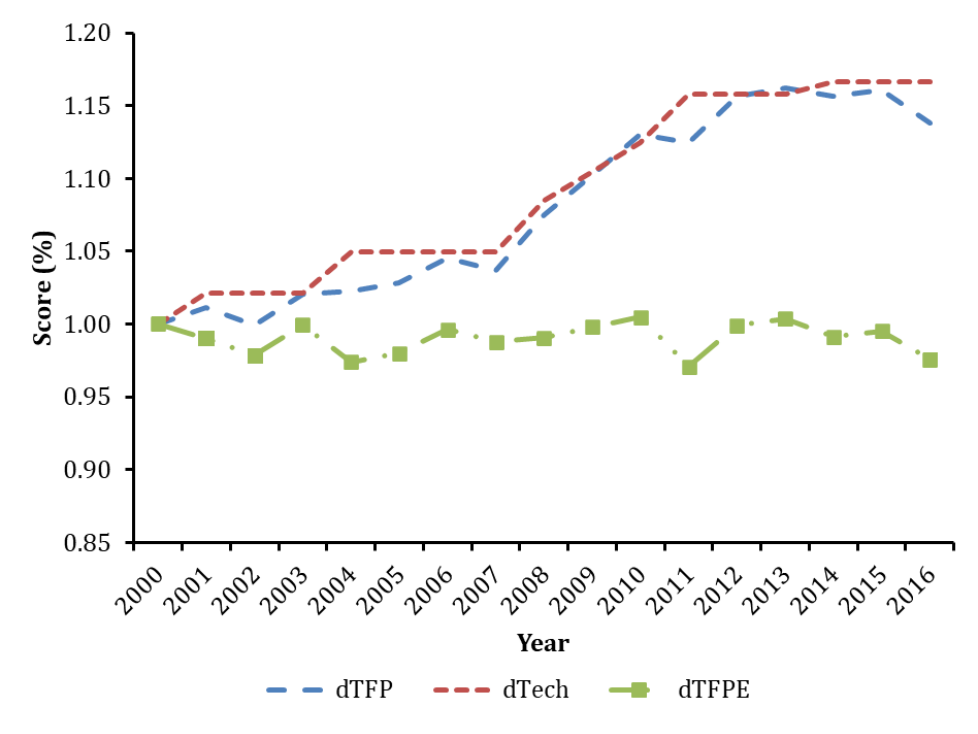
Figure 6. Yearly agricultural productivity change (dTFP) and technical change (dTech) and efficiency change (dTFPE) from 2000 to